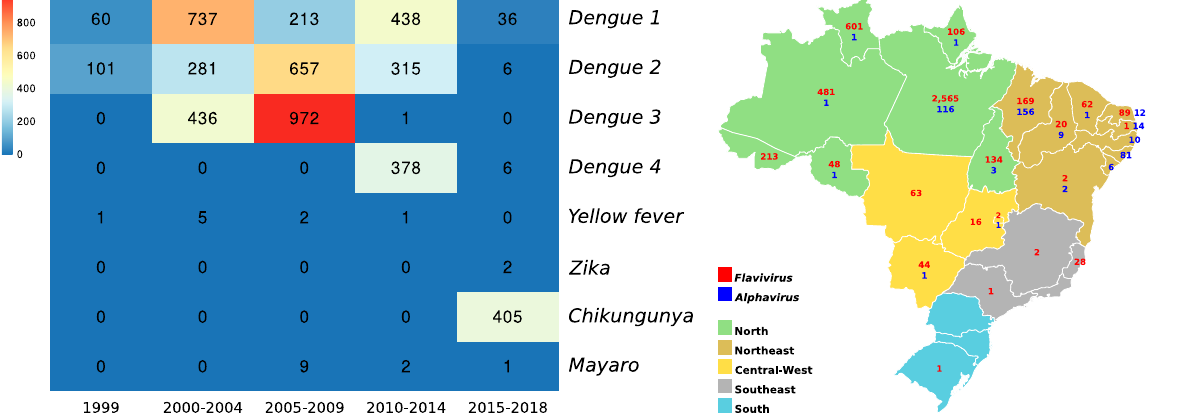
Figure 8. Distribution of alphavirus and flavivirus isolates between 1999 and 2018, from human samples and isolated exclusively using the cell culture technique. The heatmap illustrates the distribution of isolated viruses as a function of years in 5-year intervals, and the map shows the numbers of isolates in this period and distributed throughout the 5 regions of